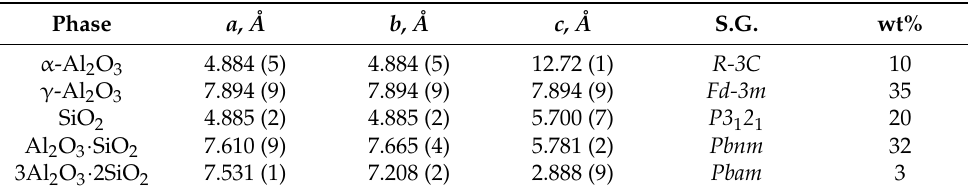
Figure 12. The observed (red dots at top), calculated (lines in the middle) and differential (blue line at the bottom) XRD patterns (in CuK α -radiation) of the PEO layer synthesized on the AK12 alloy in a weakly alkaline electrolyte of 3 g/L KOH + 2 g/L Na2SiO 3 + 3g/L H 2 O 2 composition. The numbers indicate the reflections corresponding to (1) α -Al 2 O 3 , (2) γ -Al 2 O 3 , (3) SiO 2 , (4) Al 2 O 3 · SiO 2 and (5) 3Al 2 O 3 · 2SiO 2 phases. Table 4. Crystallographic parameters and quantitative content of phases in the PEO layer syn- thesized on AK12 alloy in a weakly alkaline electrolyte of 3g/L KOH + 2 g/L Na2SiO3 + 3g/L H 2 O 2